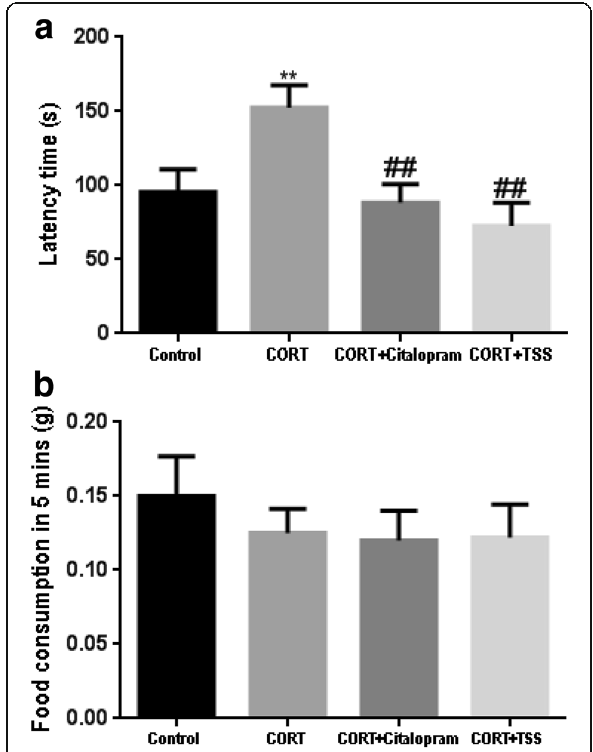
Fig. 5 Effects of TSS (25 mg/kg) and citalopram (10 mg/kg) on the NSFT in the chronic CORT treatment mice. a Latency time (s). b Food consumption in 5 mins. Data were analyzed by one-way ANOVA followed by Student-Newman-Keuls test. Each bar represents the mean ± SEM ( n = 8 – 9). ** P < 0.01, as compared with the control group and ## P < 0.01, as compared with the CORT